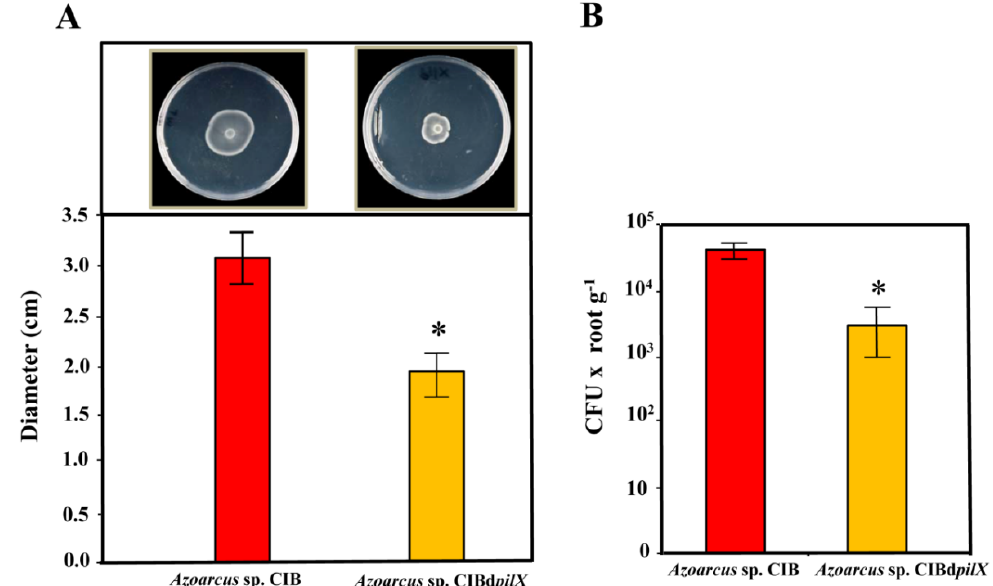
Figure 2. Motility and rice colonization phenotypes of the Azoarcus sp. CIB and Azoarcus sp. CIBd pilX strains. ( A ) Swarming motility of Azoarcus sp. CIB (carrying the control plasmid pSEVA237) (left) and Azoarcus sp. CIBd pilX (right), and quantification of the diameter of the halos ( n = 3); the error bars indicate the standard deviation. An asterisk means a significant difference ( p = 0.0377), according to paired t -test. ( B ) Quantification of the number of endophytes recovered from rice roots after inoculation of rice seedlings with the Azoarcus sp. CIB (pSEVA237) and Azoarcus sp. CIBd pilX . The graph shows the CFU values per gram of root (fresh weight) of three independent experiments; error bars indicate standard deviation. An asterisk means a significant difference ( p = 0.0219), according to paired t -test.